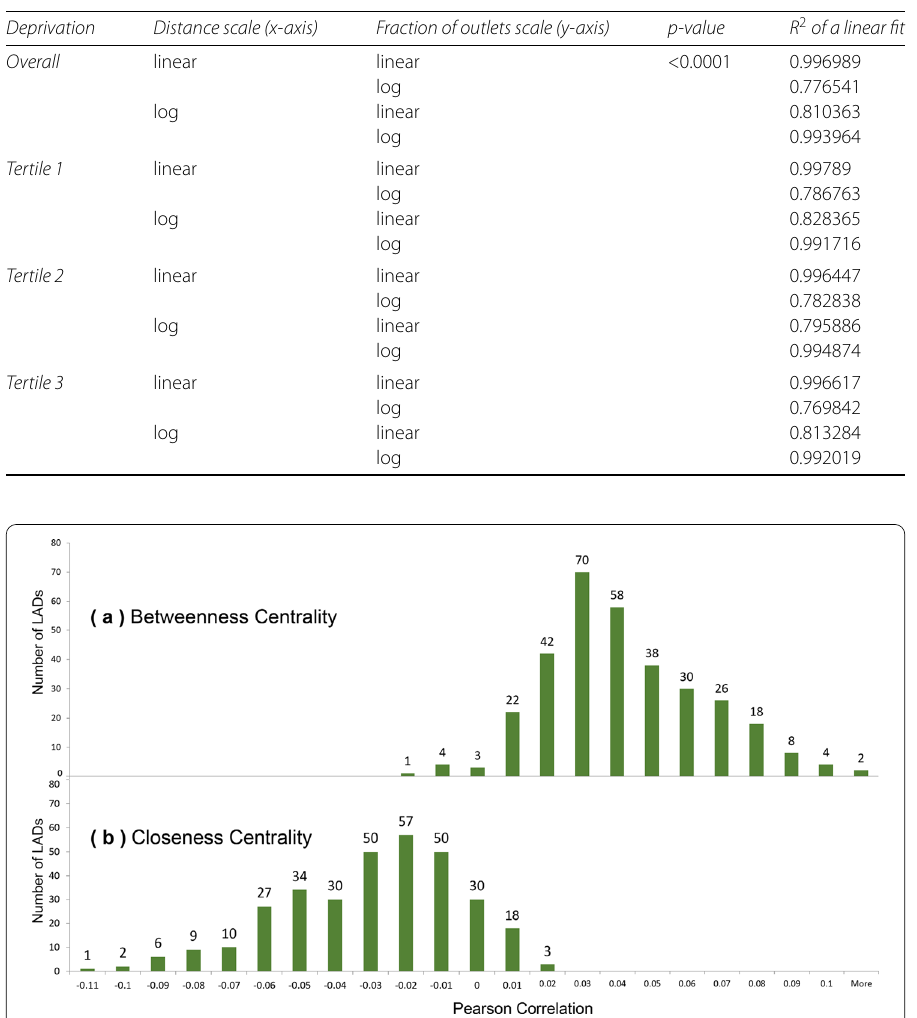
Figure 13 Distribution of Pearson correlations between the density of fast-food outlets and ( a ) betweenness centrality or ( b ) closeness centrality